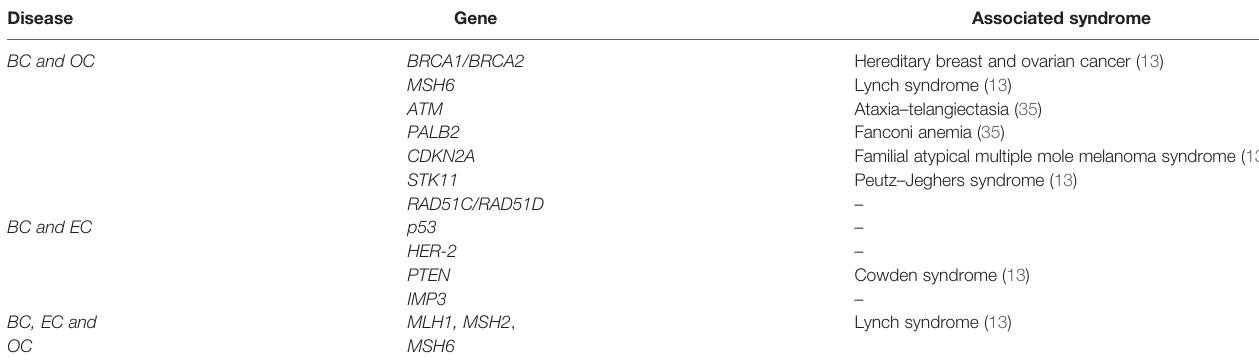
TABLE 1 | List of genetic mutations and associated syndromes in multiple primary malignancies of breast and gynecologic